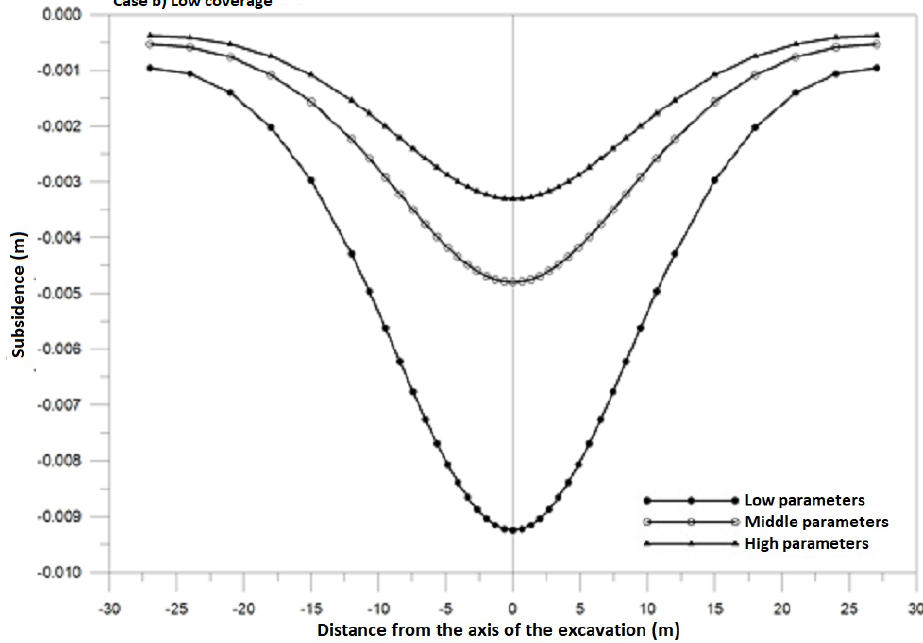
Figure 25. Settlements on the ground surface for excavation in the South Portal area with little coverage (8 m).